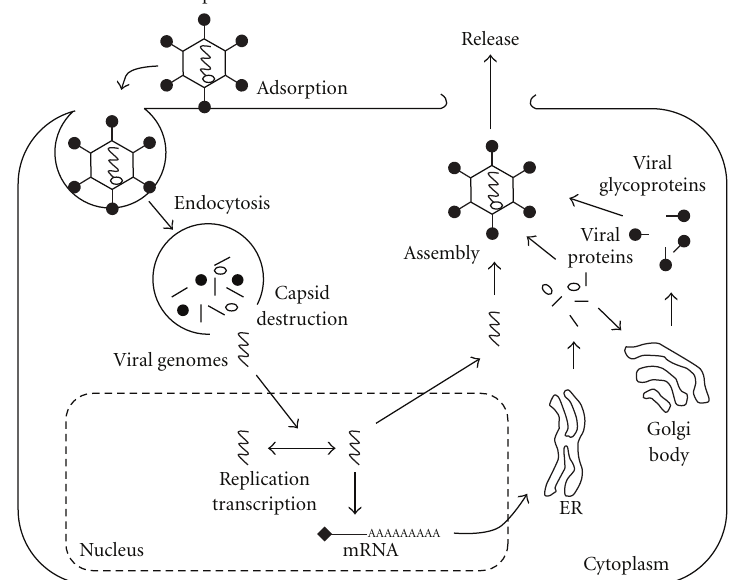
Figure 2: Entry, assembly, and budding processes of nonenveloped viruses. Nonenveloped DNA viruses, such as Adenoviridae and Papovaviridae family viruses, are incorporated into cells through endocytosis and then their viral DNA genomes are released into the cytop- lasm by viral capsid destruction. Viral genomes are subjected to replication and transcription in the nucleus. After assembly of viral proteins and genomes, progeny viruses are released from